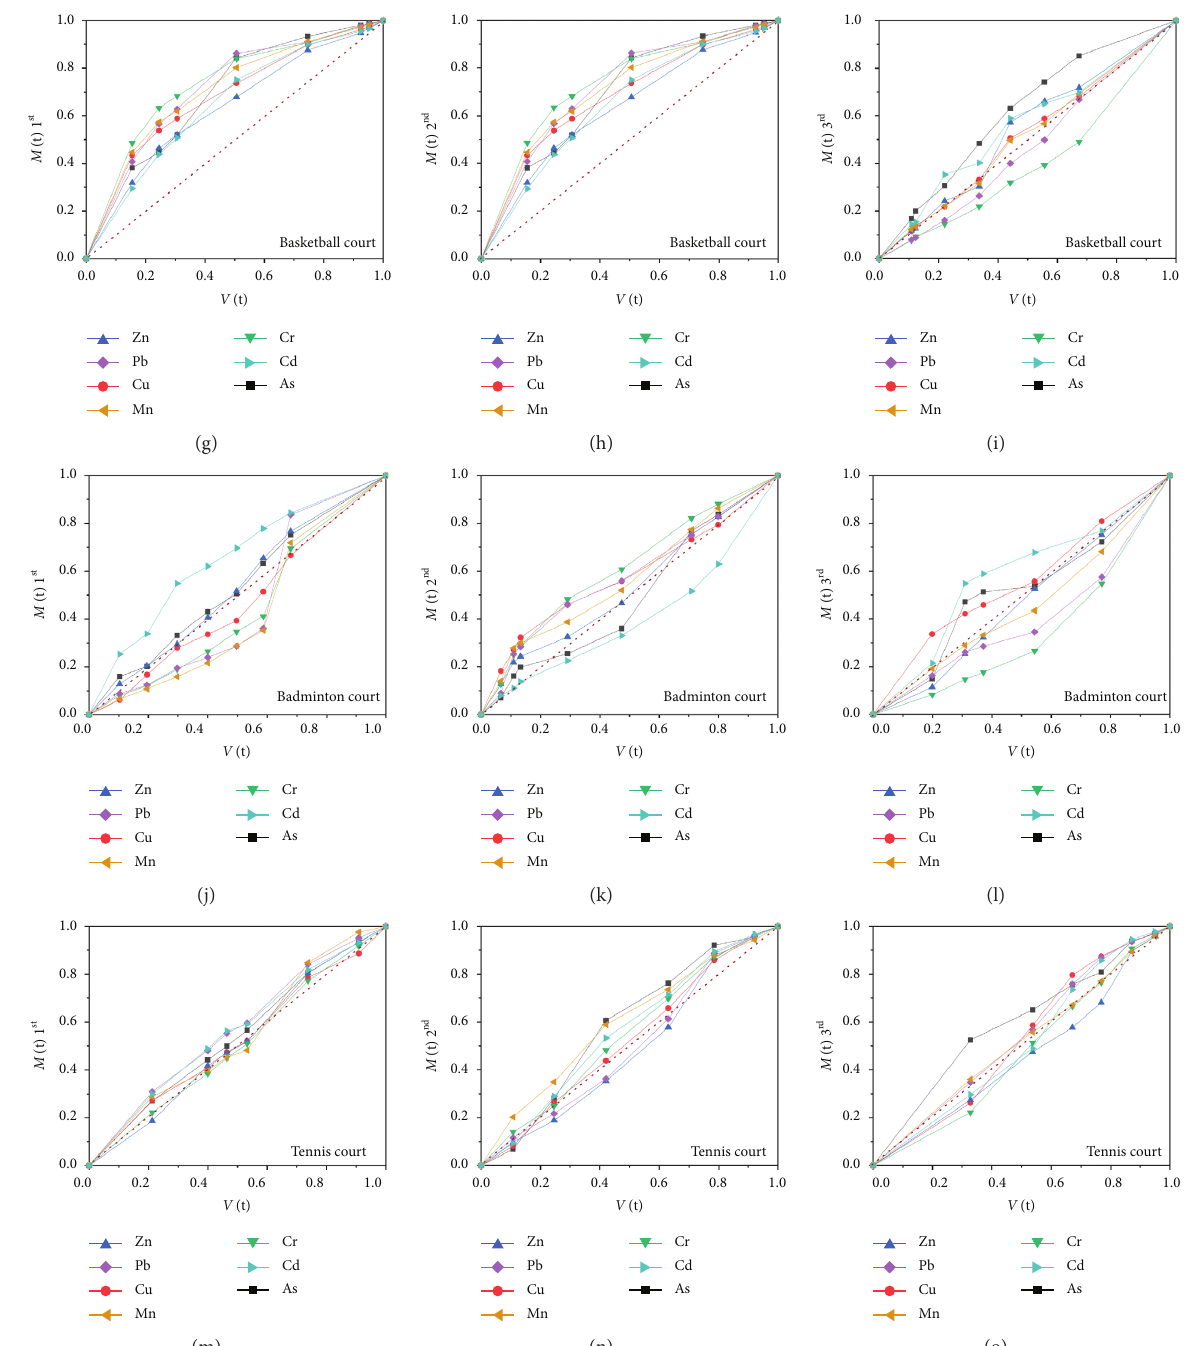
Figure 3: Cumulative mass and volume curves of metals and metalloids in the five athletic field